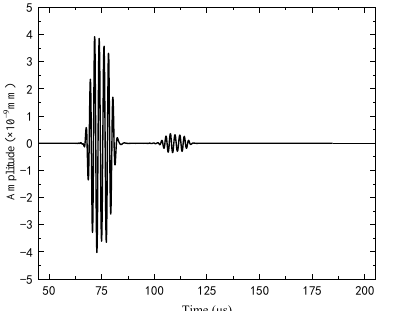
Figure 14. Time-domain waveform of received EMUS signal .